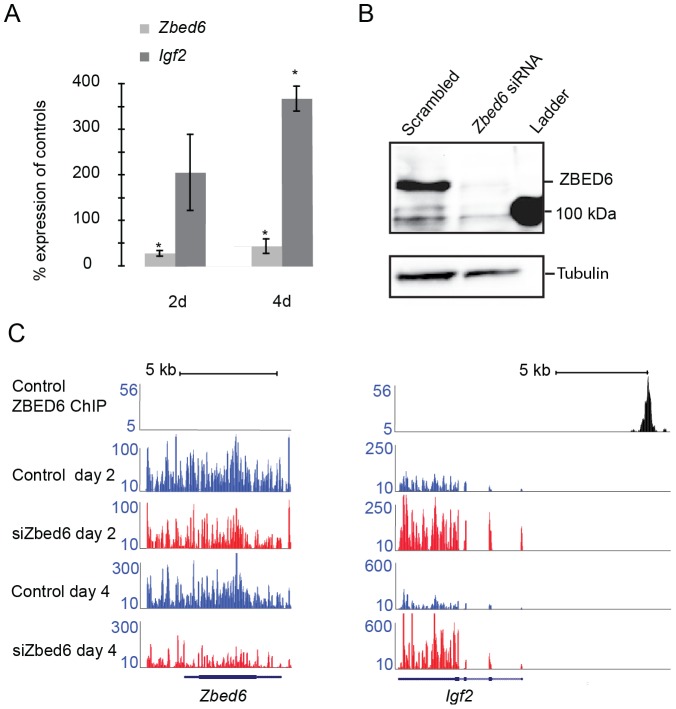
RNA sequencing of Zbed6-silenced myoblast cells.(A) Quantitative PCR validation of Zbed6-silencing (light gray bar) and Igf2 up-regulation (dark gray bar) two and four days post-Zbed6 siRNA transfection. Biological triplicates were performed for both Zbed6 and scrambled siRNA. Error bars, s.e.m. The asterisk indicates a significant difference (P<0.05) between control and Zbed6-silenced samples. (B) Western blot validation of Zbed6-silencing. The protein lysates from the pooled biological triplicates for each siRNA treatment were equally loaded to the protein gel after measuring the concentration. The specific band for ZBED6 protein (110 kDa) appeared above the 100-kDa band from the protein ladder and α-Tubulin was used as a reference protein. (C) Direct comparison of the read counts (y-axis) from Zbed6-silenced and negative control RNA-seq data across Zbed6 and Igf2 regions for both two and four days post siRNA transfection. The ChIP-seq data with ZBED6 antibody from Markljung et al. [1] are shown to pinpoint the binding sites of ZBED6.